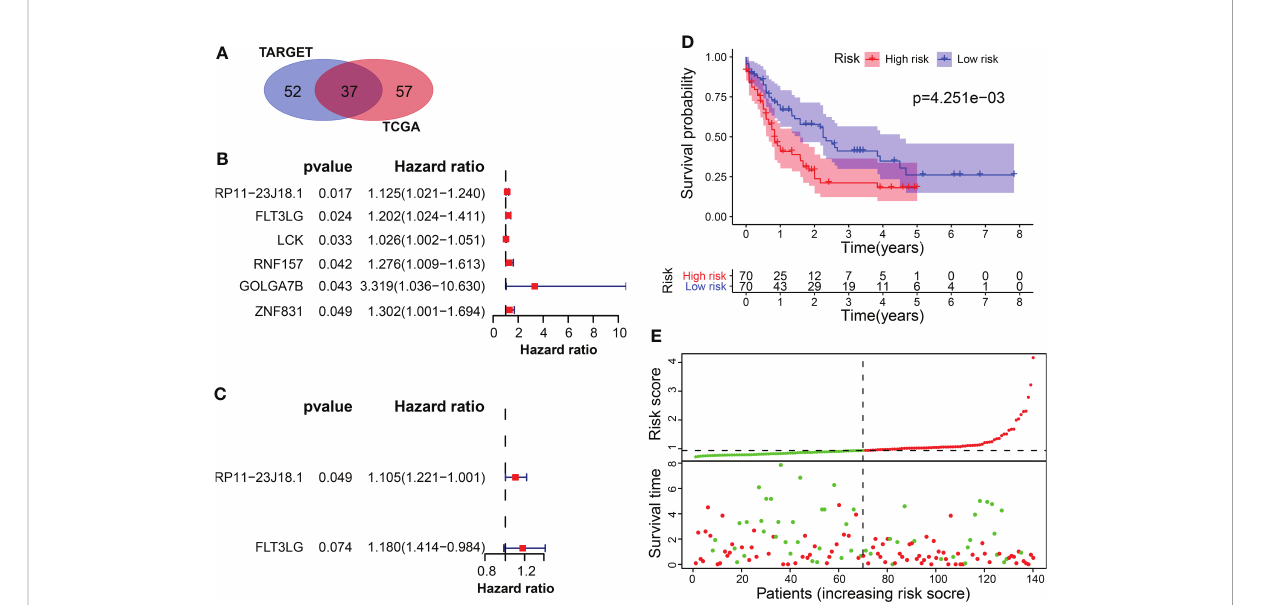
FIGURE 3 Screening of survival-related differentially expressed genes. (A) The intersection of candidate genes in TCGA and TARGET datasets. (B) Univariate cox regression analysis of 6 survival-related genes in TCGA. (C) Multivariate cox regression analysis included RP11-23J18.1 and FLT3LG as survival predicting gene models in TCGA. (D, E) Application of the survival predicting model in TCGA